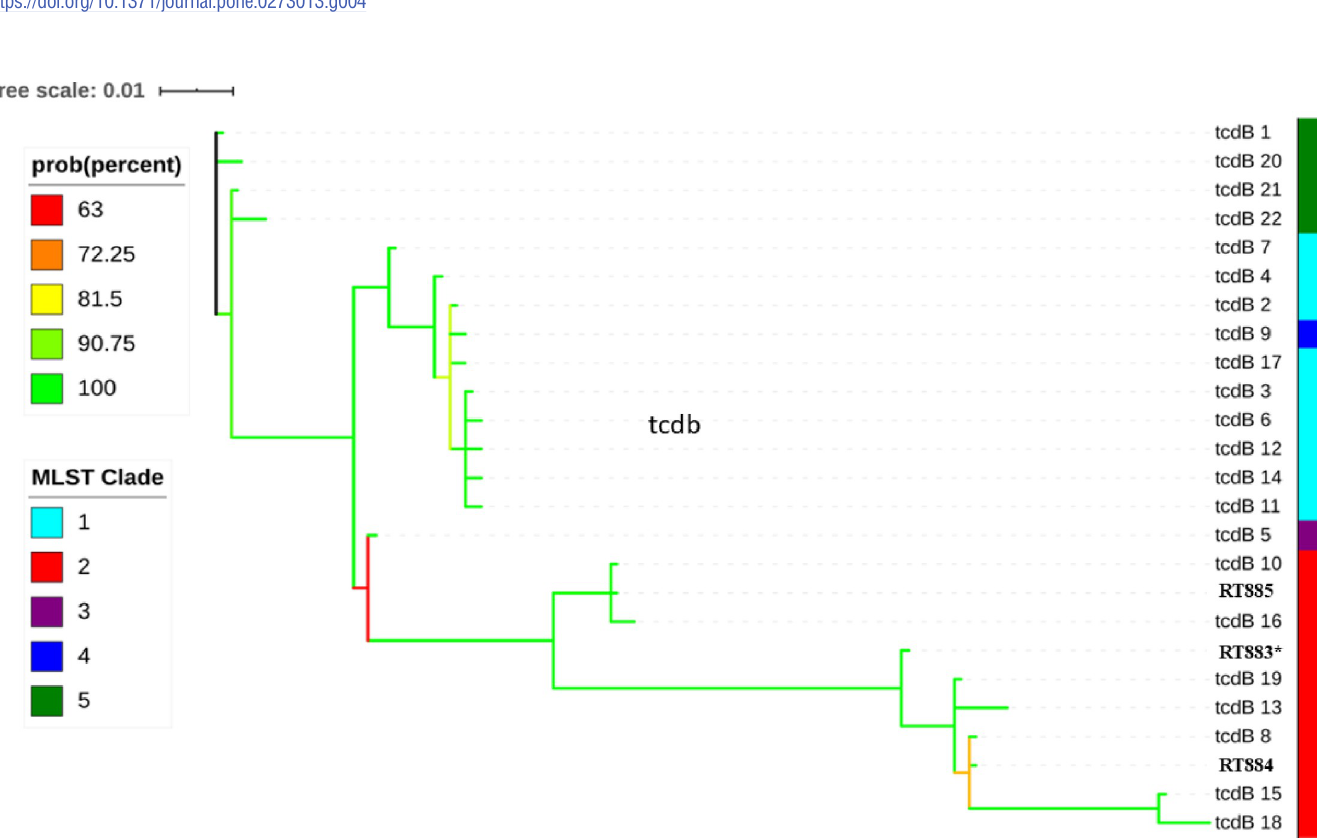
PLOS ONE | https://doi.org/10.1371/journal.pone.0273013 August 26,